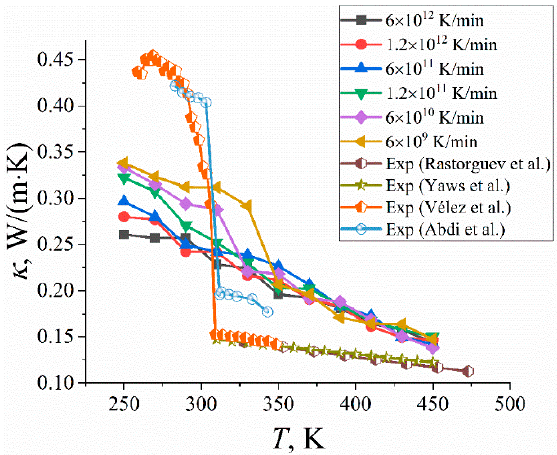
Figure 3. The thermal conductivity coefficient κ of n-eicosane samples as a function of temperature T for different cooling rates. For the sake of comparison, the experimental data are also shown